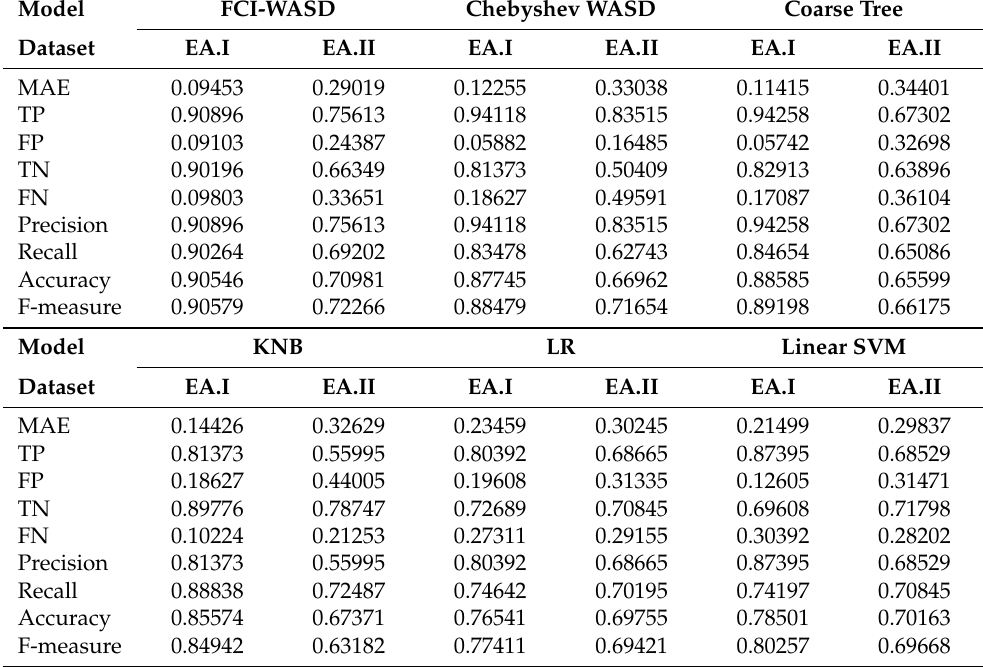
Table 1. Collective results of all models on the testing set of each dataset.